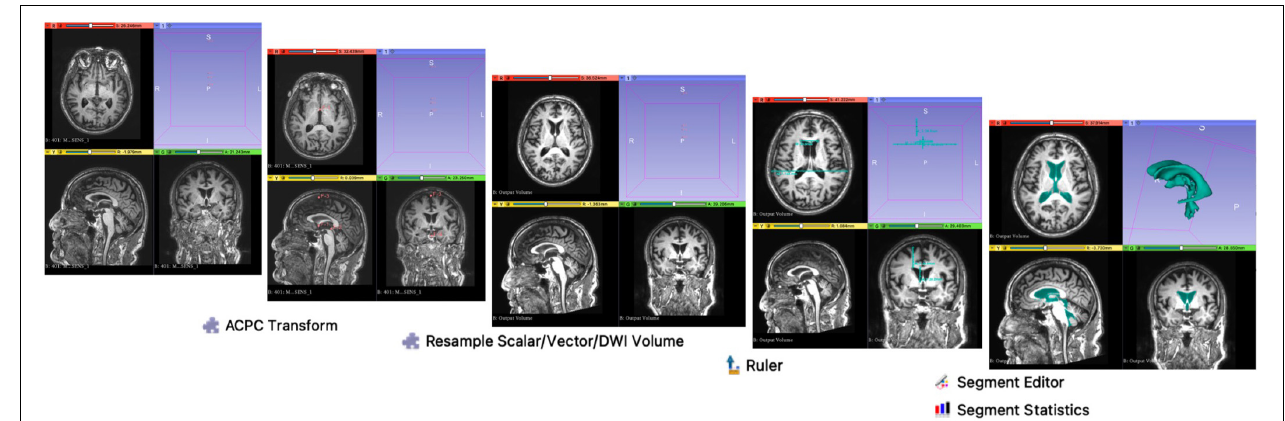
FIGURE 2 | Methodology on 3D Slicer. Using the ACPC Transform and the Resample Scalar/Vector/DWI Volume modules, planes of the T1-weighted DICOM scans were re-aligned parallel to the ACPC line for accurate replication of the alignment at a typical radiology workstation, as per Yamada et al. (2017). Ruler Module was used to extract measurements for the various morphological indices. Segment Editor was used for the semi-automated segmentation of the ventricles. Segment Statistics was used to derive ventricular volumes by automatic counting of voxels in